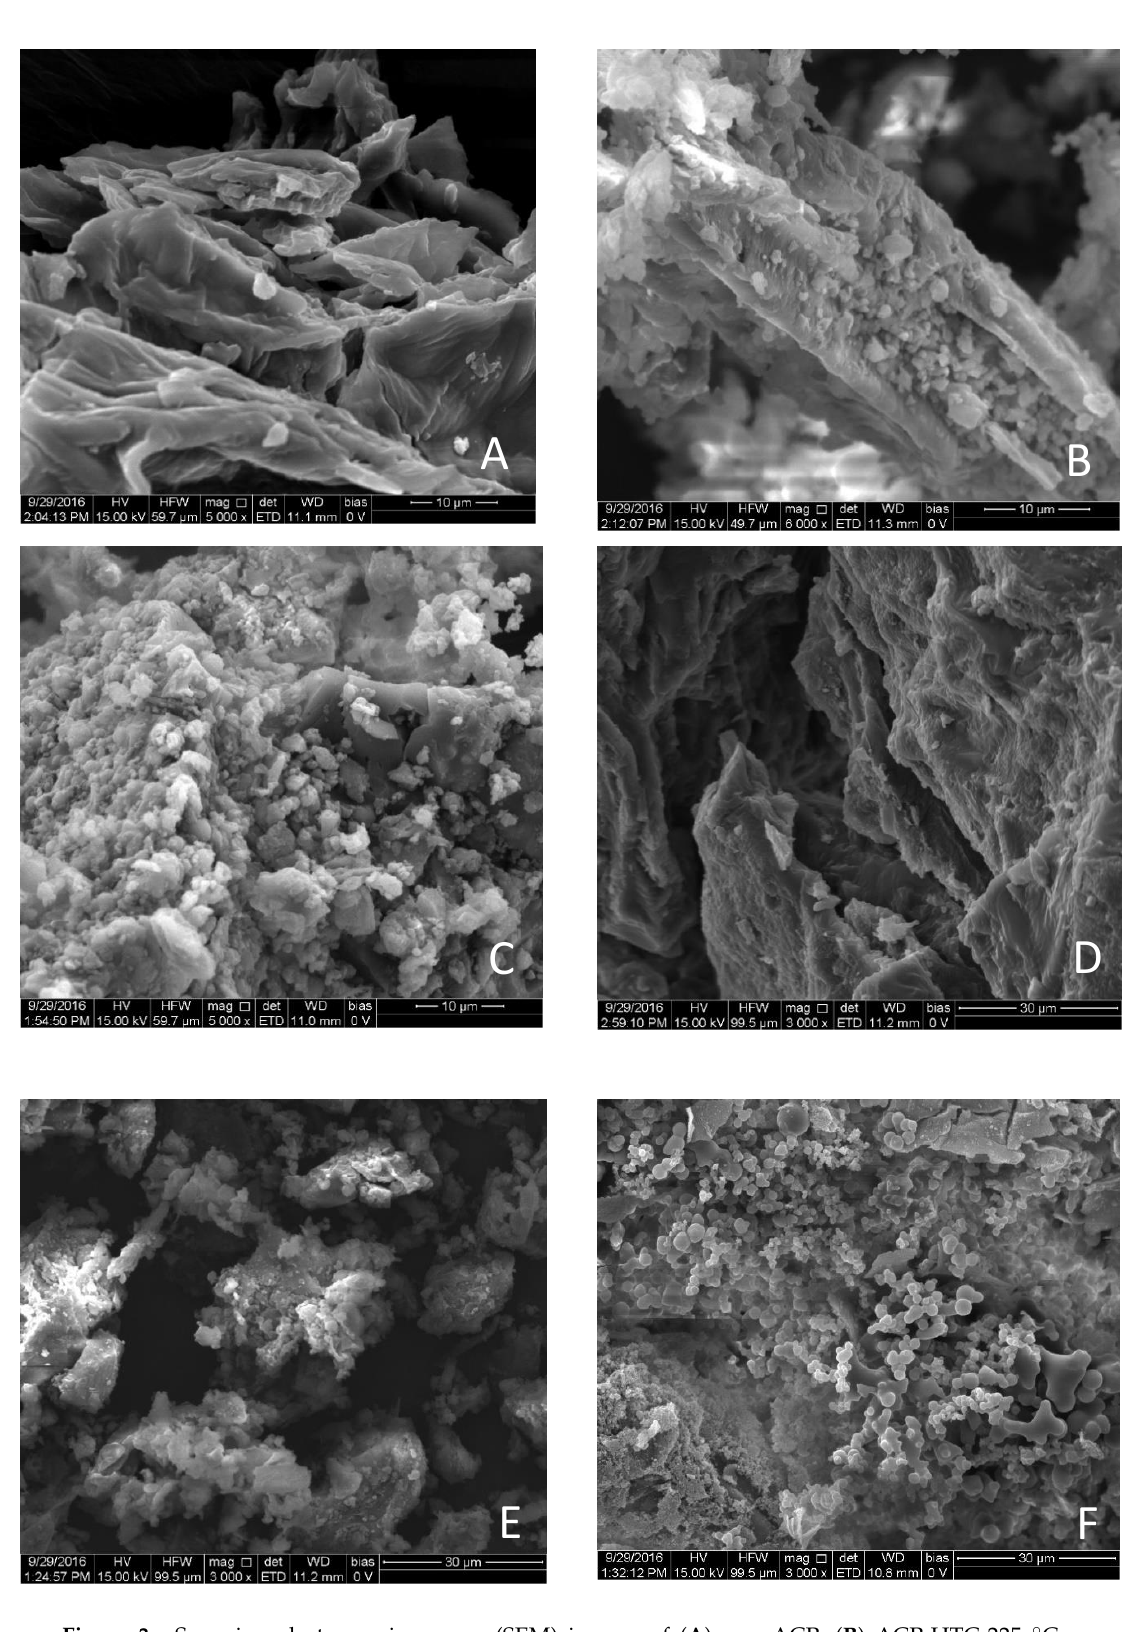
Figure 3. Scanning electron microscopy (SEM) images of ( A ) raw ACP; ( B ) ACP-HTC-225 ◦ C; ( C ) ACP-HTC-260 ◦ C; ( D ) raw GP; ( E ) GP-HTC-190 ◦ C; ( F ) GP-HTC-225 ◦